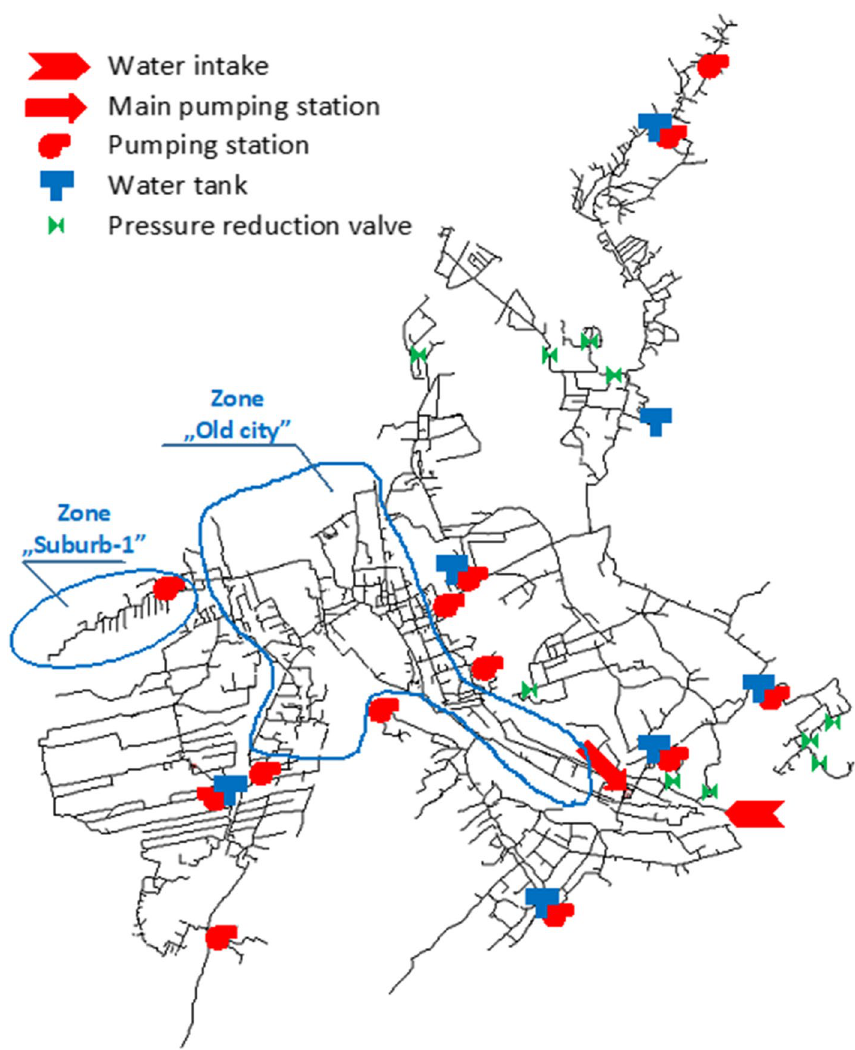
Fig. 2 Scheme of the geometri- cal structure of a water supply system with the location of the intake, pumping station, and network